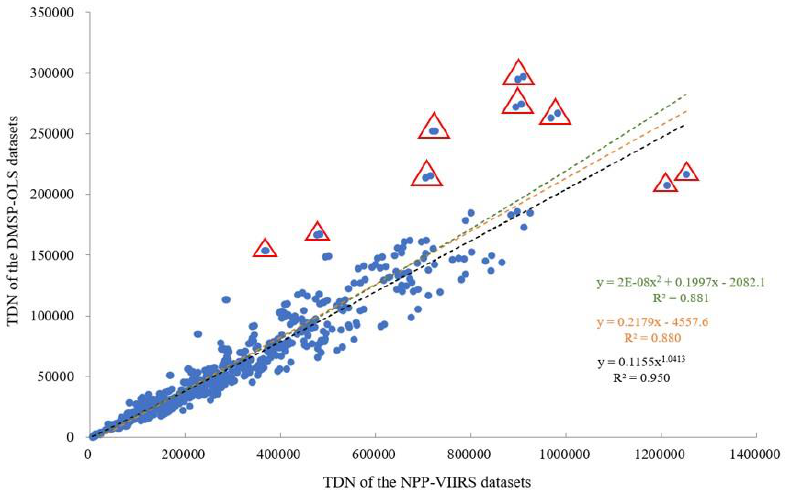
Figure 1. Relationship between the total digital pixel numbers (TDN) of the DMSP-OLS and NPP-VIIRS data in 2012 and 2013. The red triangle frames in the picture represent the cities that deviated greatly from the regression line.